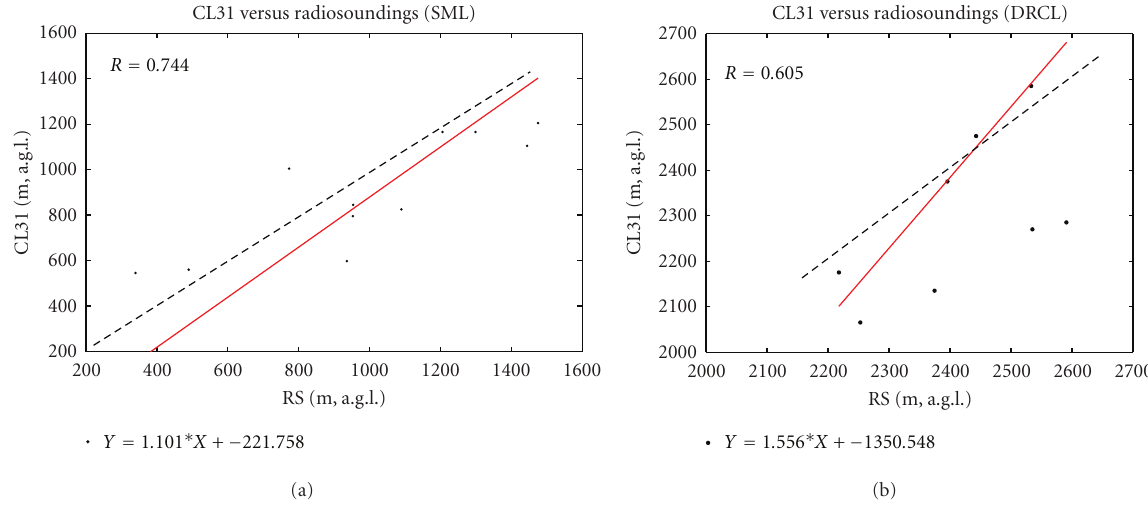
Figure 8: CL31-RS comparison and linear correlation for SML and DRCL